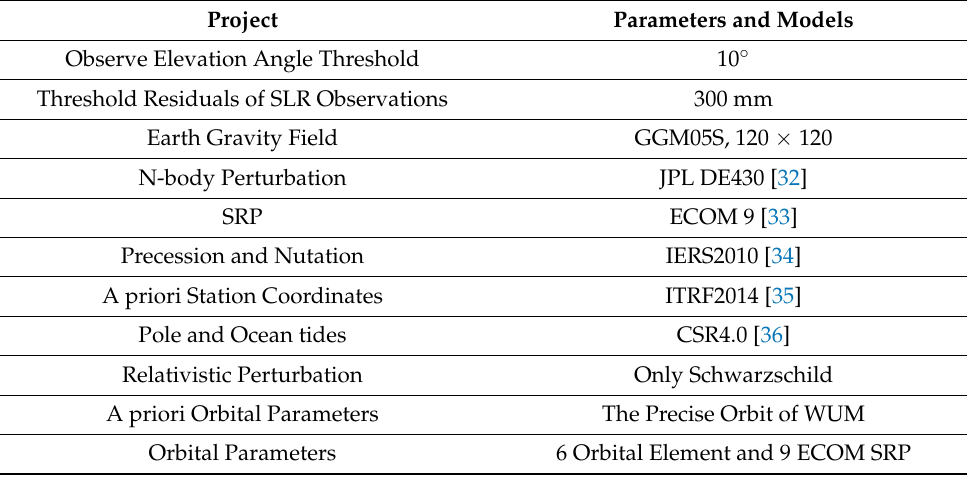
Table 1. The con fi guration of parameters of SLR-only orbit determination. Table 1. The configuration of parameters of SLR-only orbit determination.